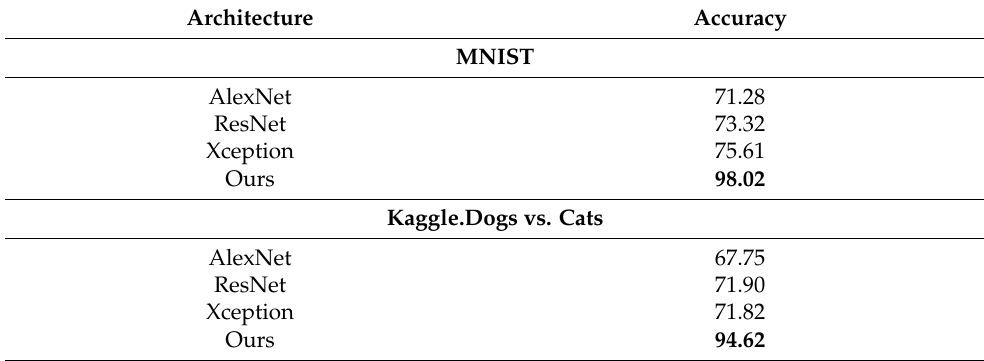
Table 9. Percentage of correct recognitions.